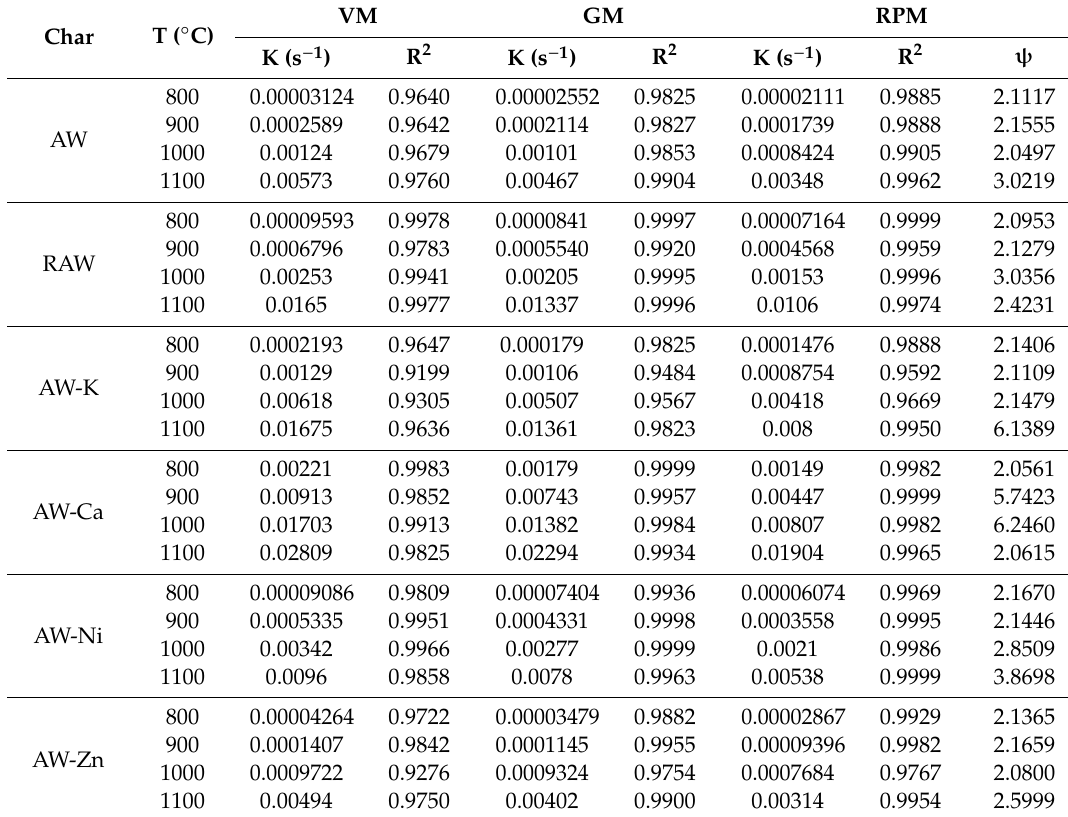
Table 2. The kinetic and empirical parameters of three employed